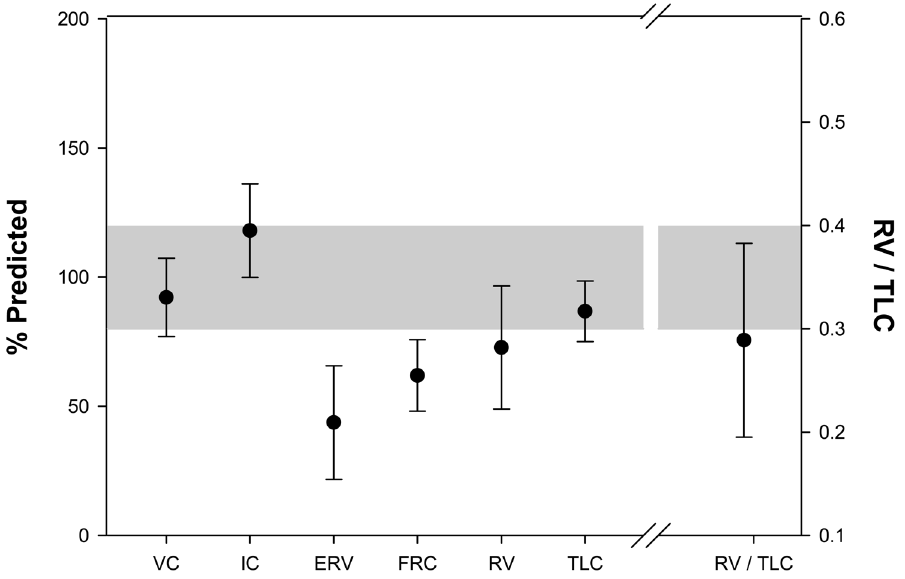
Figure 2. Baseline lung volumes are illustrated. Data are expressed as mean 6 SD. Shaded area represents normal range.